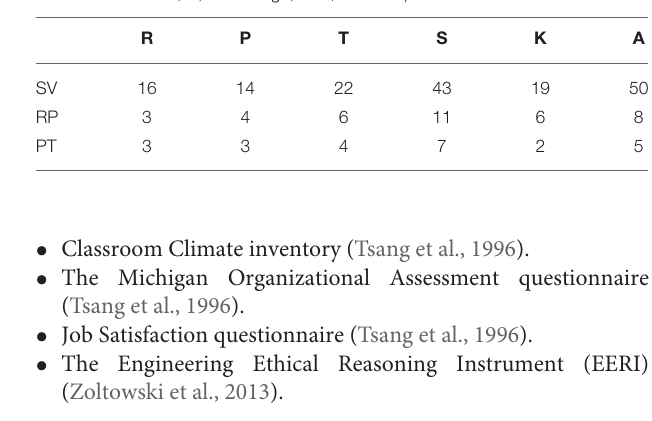
TABLE 1 | Search results related to surveys (SV), reports (RP), and Presentations (PT) related to the learning outcomes that are measured (R,